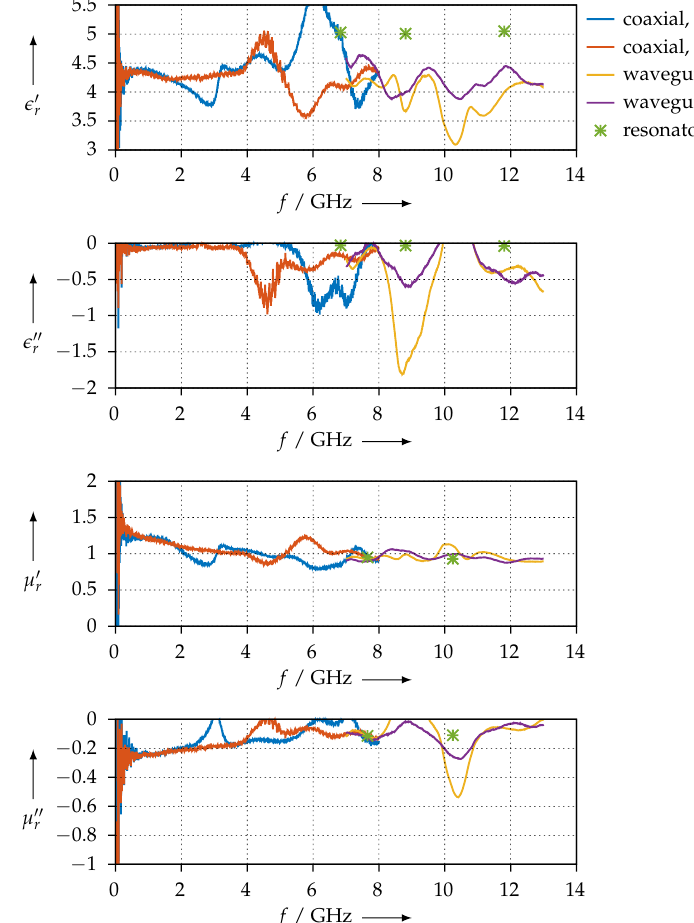
Figure 22. Real ( (cid:101) (cid:48) r , µ (cid:48) r ) and imaginary ( (cid:101) (cid:48)(cid:48) r , µ (cid:48)(cid:48) r ) parts of the permittivity and permeability for the FEP material.